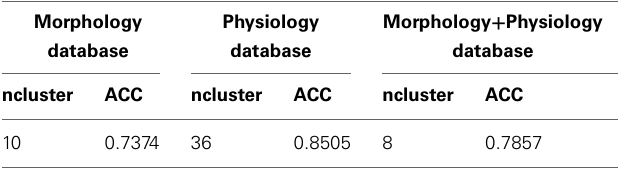
Table 1 | Accuracies computed for the Morphology, Physiology, and Morphology + Physiology